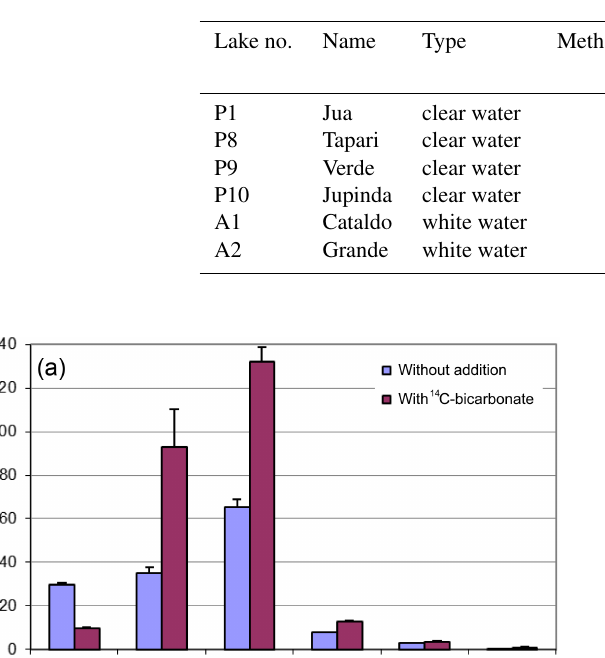
Table 1. Identity of sediment samples (following Ji et al., 2016) and percentage content of putatively acetoclastic methanogens (Methanosae- taceae) relative to total archaea and concentrations of acetate (mean ± SE).